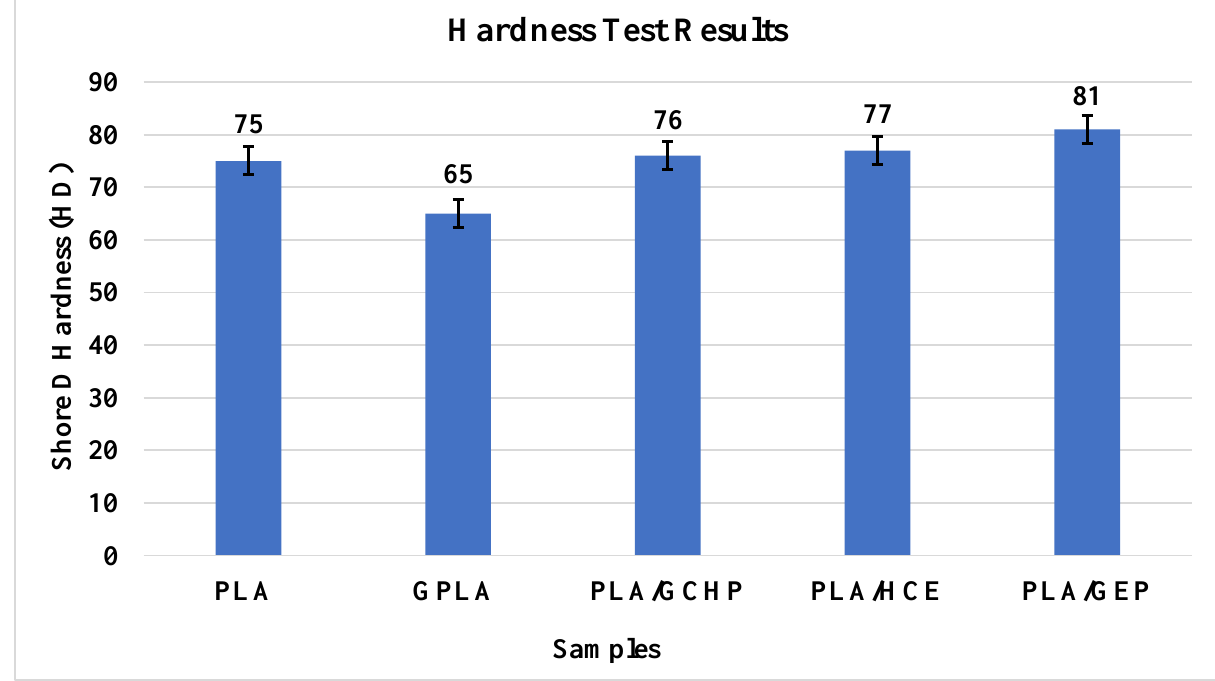
Figure 11. Results from hardness testing.